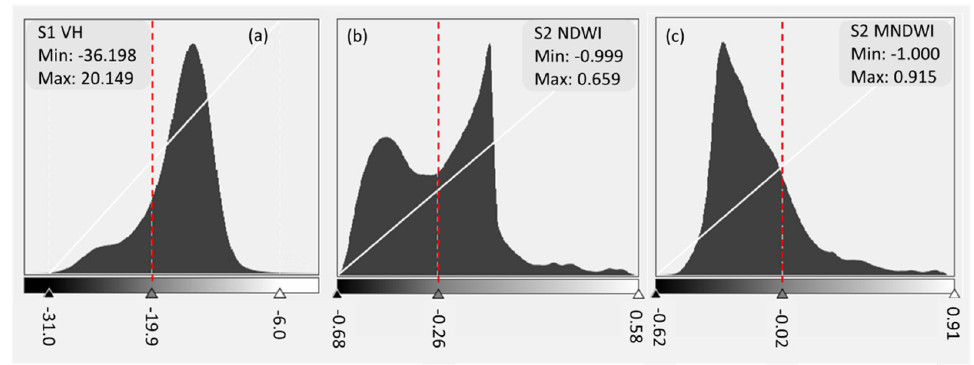
Figure 11. Histograms of Sentinel-1 VH ( a ), Sentinel-2 NDWI ( b ), and Sentinel-2 MNDWI ( c ) images acquired on 11 April 2017. The dashed lines in red color are the optimal Otsu thresholds.